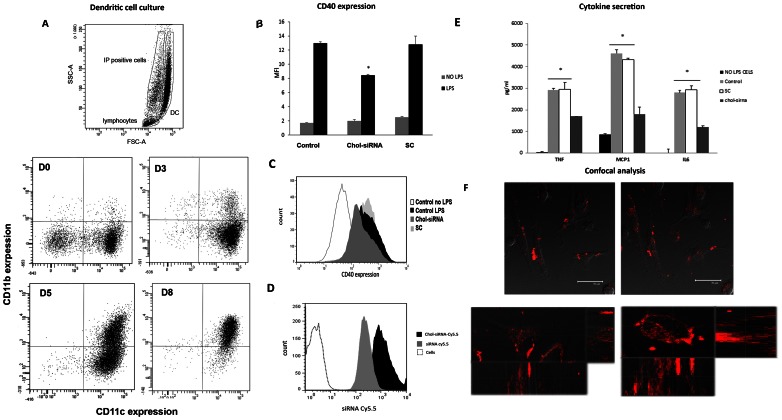
Representative flow cytometry analysis of DC culture.A) DC culture development. Lymphocytes (CD3+) and death cells (IP positive) were discarded. DCs were backgated using a FSC-A/SSC-A dot plot. Subsequently, CD11c and CD11b expression were assessed in DC population using CD11c APC/CD11bPE dot plot. D0, D3, D5 and D8 = day 0, 3, 5 and 8 respectively B) CD40 expression of DC with and without LPS stimuli and transfected with Chol-siRNA or SC siRNA were analyzed by flow cytometry (MFI). *p<0.05 vs control and scrambled. C) Representative histograms for each group of treatment. D) Representative histograms of siRNA internalization analyzed by flow citometry (MFI). E) DC cytokine secretion after LPS stimulus and Chol-siRNA effect. F) Chol-siRNA Cy5.5 internalization in DCs is shown at time 0 and after 45 min of incubation (upper left and right photomicrograph x630, respectively). Middle and bottom photomicrographs: Z-scan image of live DC cells where we can observe siRNA cytoplasm localization and confocal projections of the cell to the xz and zy planes (sideviews). Data are expressed as mean± SEM of four separate experiments.